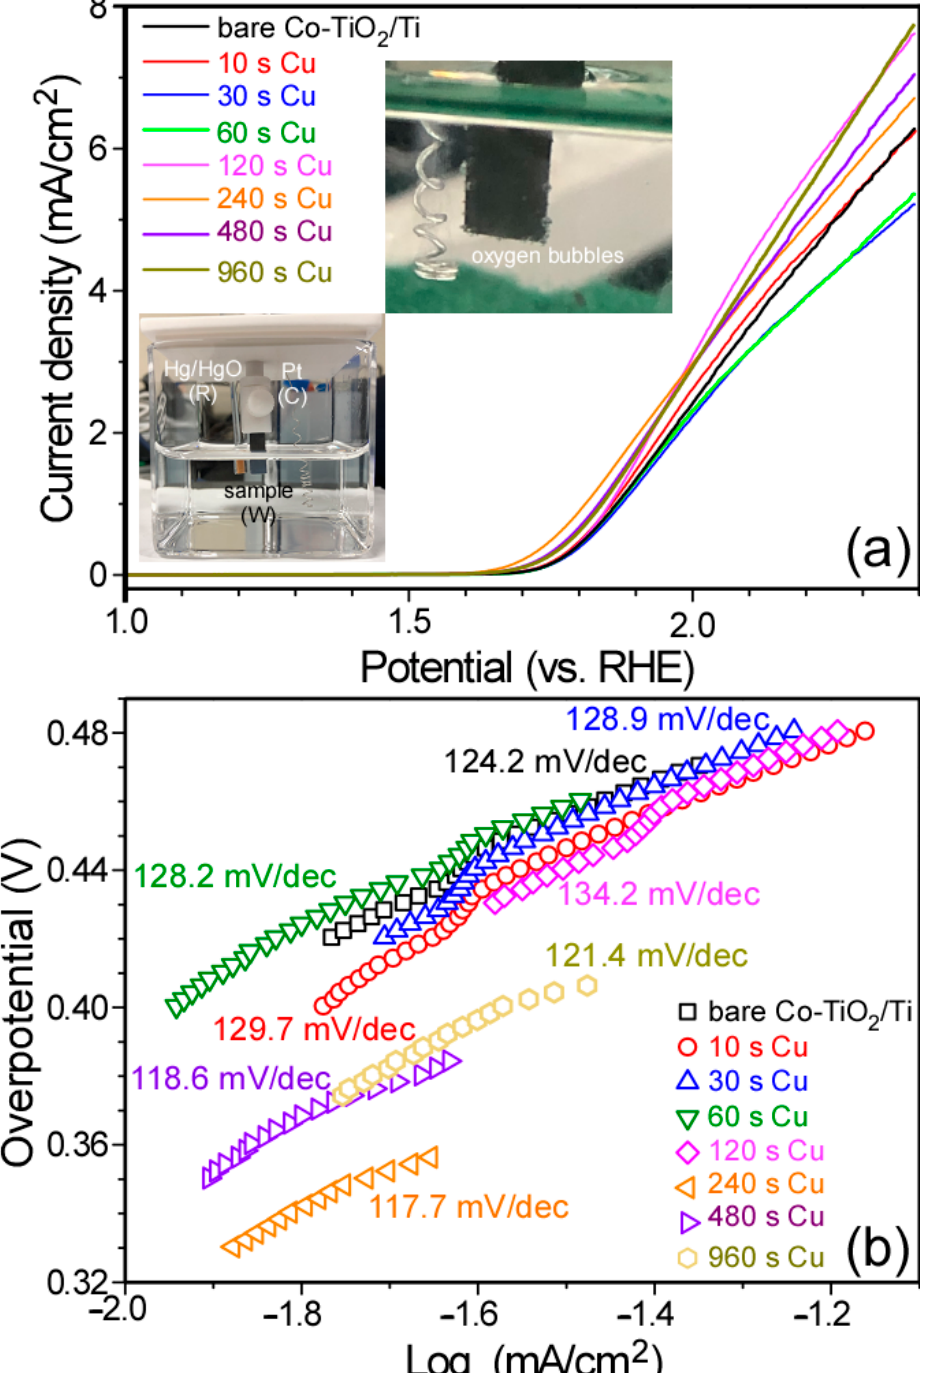
Figure 9. Linear sweep voltammetry profiles ( a ) for bare Co-TiO 2 /Ti and 10s, 30 s, 60 s, 120 s, 240 s, 480 s and 960 s-Cu-deposited Co-TiO 2 /Ti samples and the corresponding Tafel plots ( b ). Inset photos show the electrochemical cell with the three electrodes and oxygen bubbles on a catalyst surface.